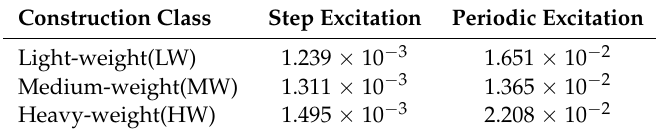
Figure 6. Temperature dynamics of reference, optimized and comparison models for heavy weight wall. Table 3. Root mean square error (RMSE) between reference and simplified thermal network